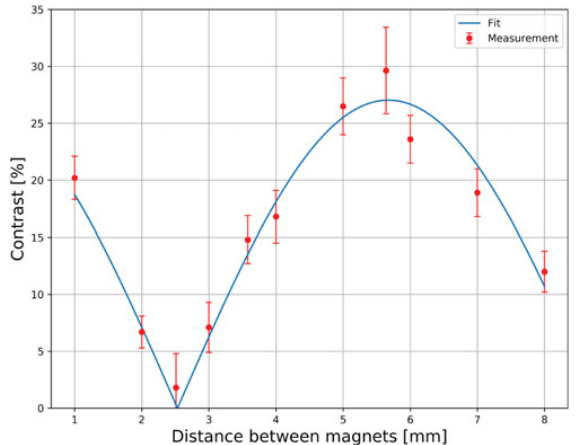
Figure 7. Polarimetric measurements with a 3D printed spin flipper. The blue (red) curve shows the intensity modulation at the analyzer as a function of position of a DC coil for spin rotation without (with) spin flipper inserted in the beam for a gap size (cid:5) z of 2.25 mm.